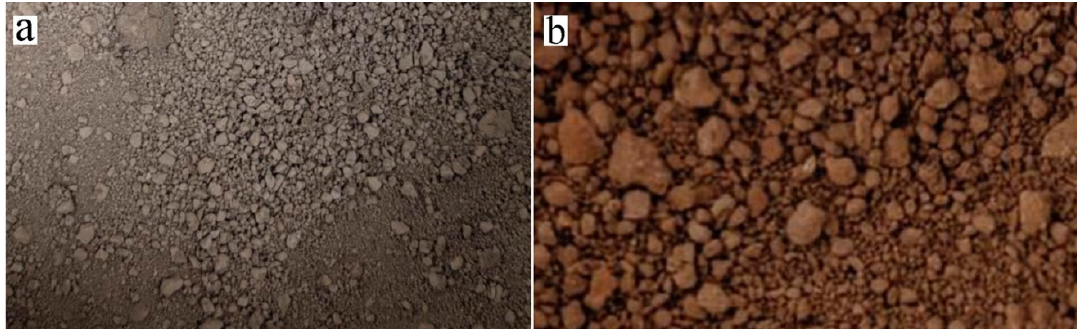
Figure 3. Image of unroasted sample ( a ) and roasted sample at 500 °C for 2 h ( b ).